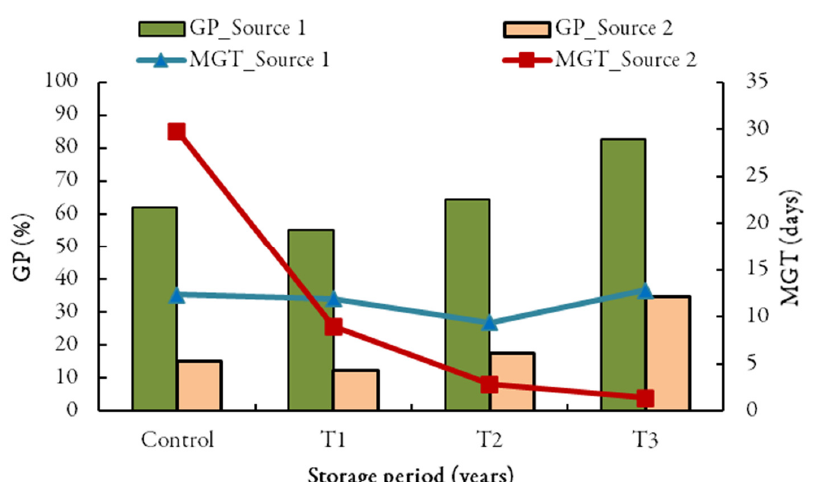
Figure 3. Germination Percent (GP) and Mean Germination Time (MGT) of Pyrus pashia seeds from Source 1 (Champawat) and Source 2 (Pithoragarh) in cold storage (5 °C) after T1- 1 year storage, T2- 2 years storage and T3- 3 years storage